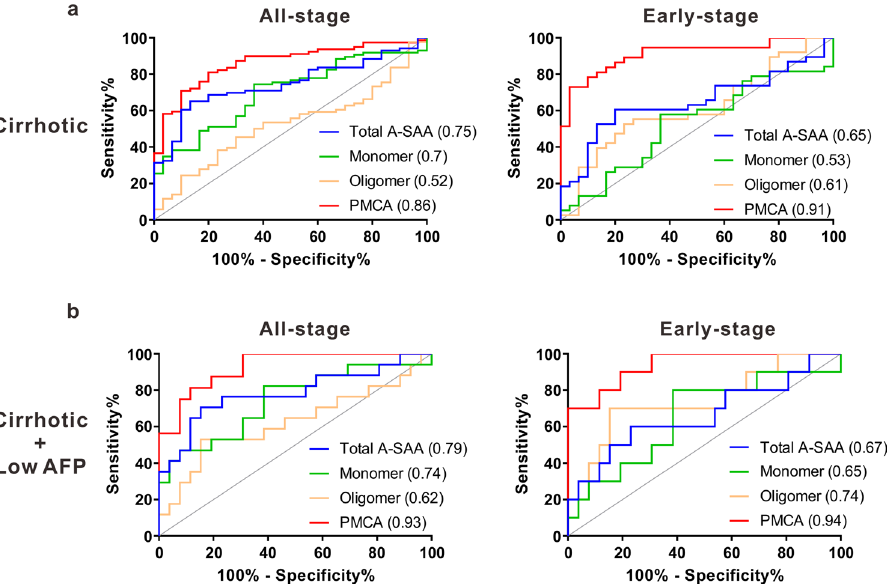
Figure 6. ROC curves of A-SAA derived biomarkers in discrimination of all-stage and early-stage HCC in cirrhotic patients with or without low AFP level. ( a ) Detection of HCC in all cirrhotic patients. ( b ) Detection of early-stage HCC in cirrhotic patients with low AFP. AUROC value for each curve is shown in